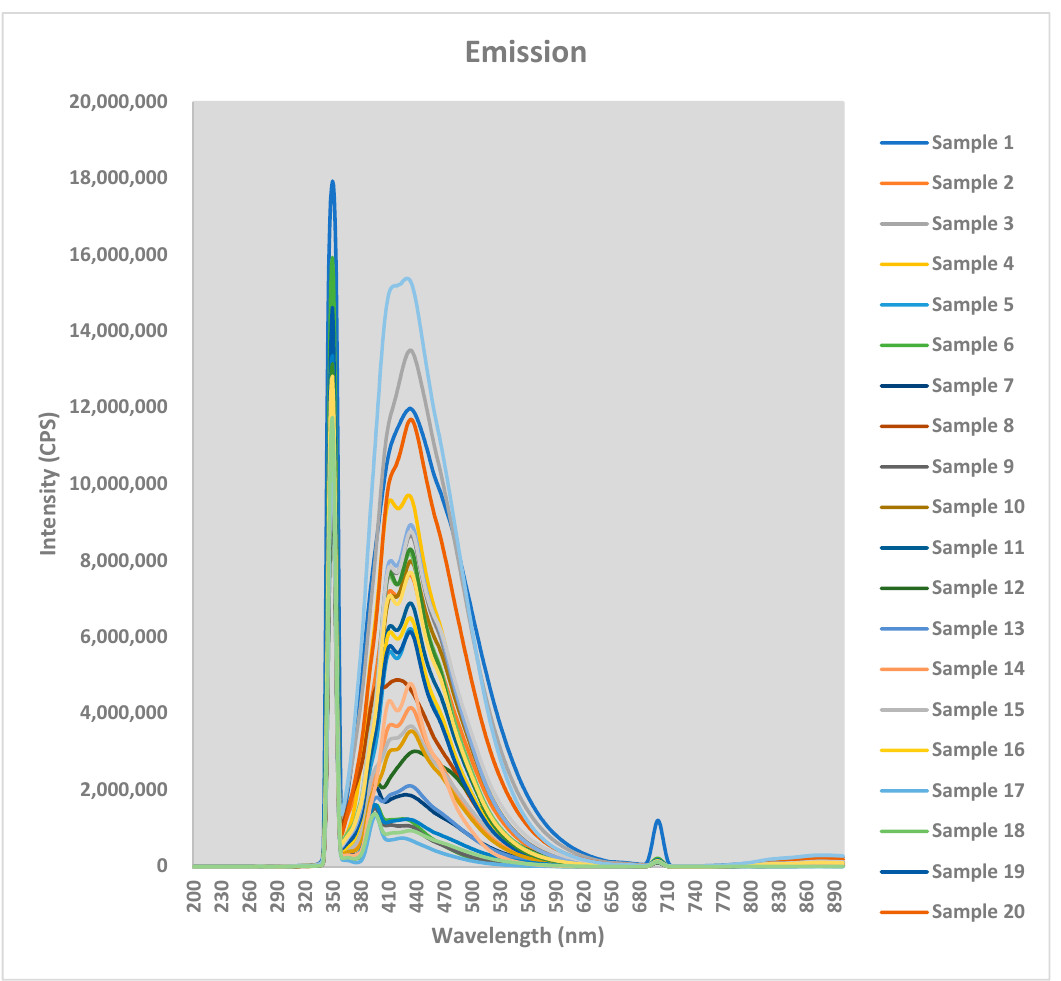
Figure 2. Emission spectra of all thirty baijiu samples. The excitation spectra for all thirty baijiu spirits did not have any distinguishable differences and had maxima at 467, 765, 822, and 883 nm. Differences in the emission spectra were observed corresponding to the intensity levels at the observed maxima 350, 435, and 700 nm; the excitation wavelength used was for emission was 350 nm. Table 1 shows price differences for the different samples that were analyzed. Sample brand names were left off due to privacy. Table 1. Baijiu spirit samples and price/L in USD.